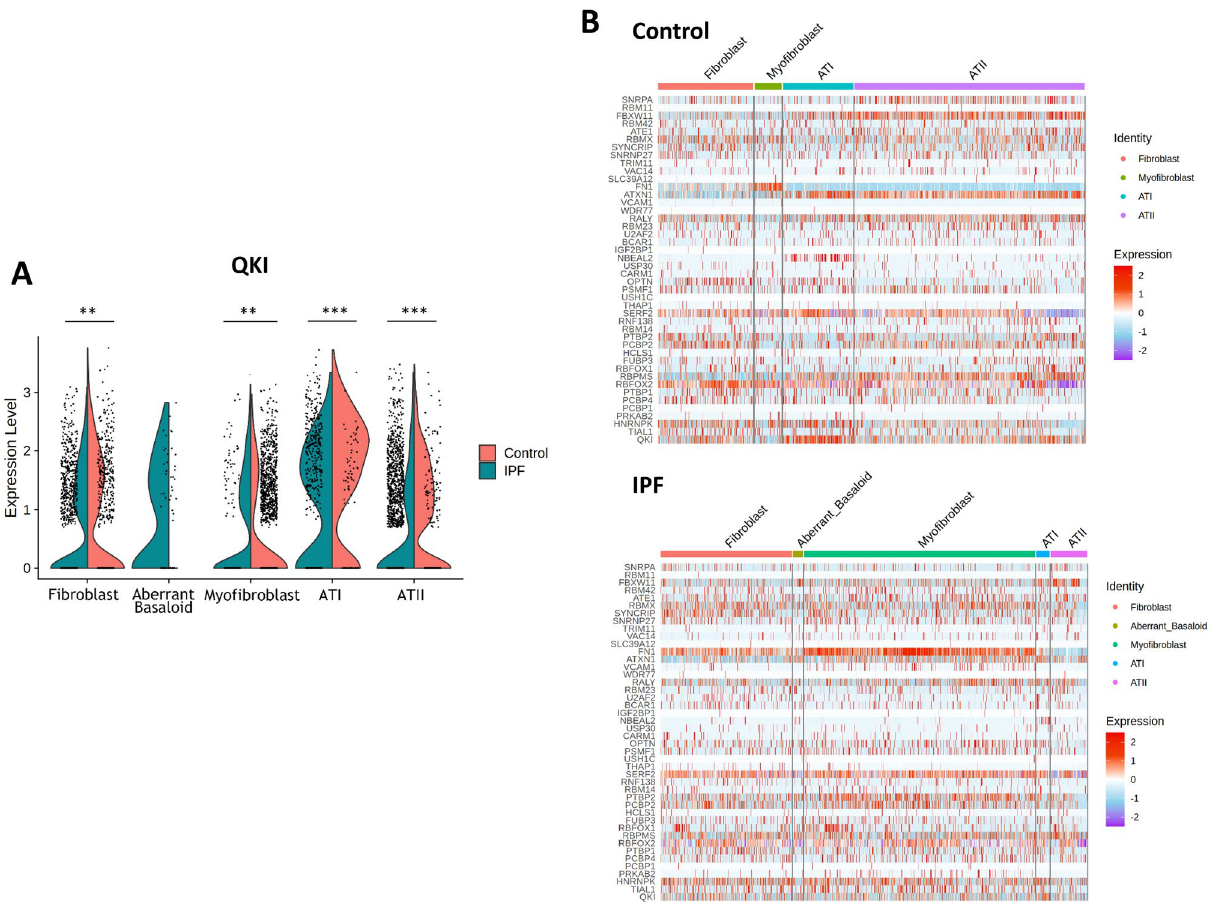
Figure 2. Gene expressions of QKI-interactome members in single-cell RNA-Seq data of IPF (n = 32) and controls (n = 28) (GSE136831 14 ; Supplementary Figure 1A shows the identified 39 cell clusters in the dataset). ( A ) Sub-fractions of several pathophysiologically relevant cell populations show low QKI expression patterns in IPF. ( B ) Heatmap illustrating the gene expression of the QKI-interactome in various subpopulations of the single-cell RNA-Seq data in control or IPF cohorts (color scaling shows the gene expression level for given genes and cells in the IPF, red: highest, blue: lowest; see Supplementary Figure 1B–D for all interactome members) (*p < 0.05, **p < 0.01, ***p < 0.001; Welch